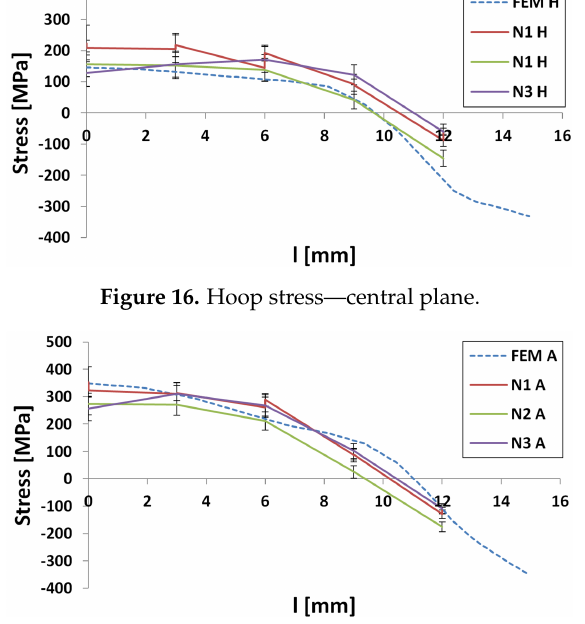
Figure 17. Axial stress—central